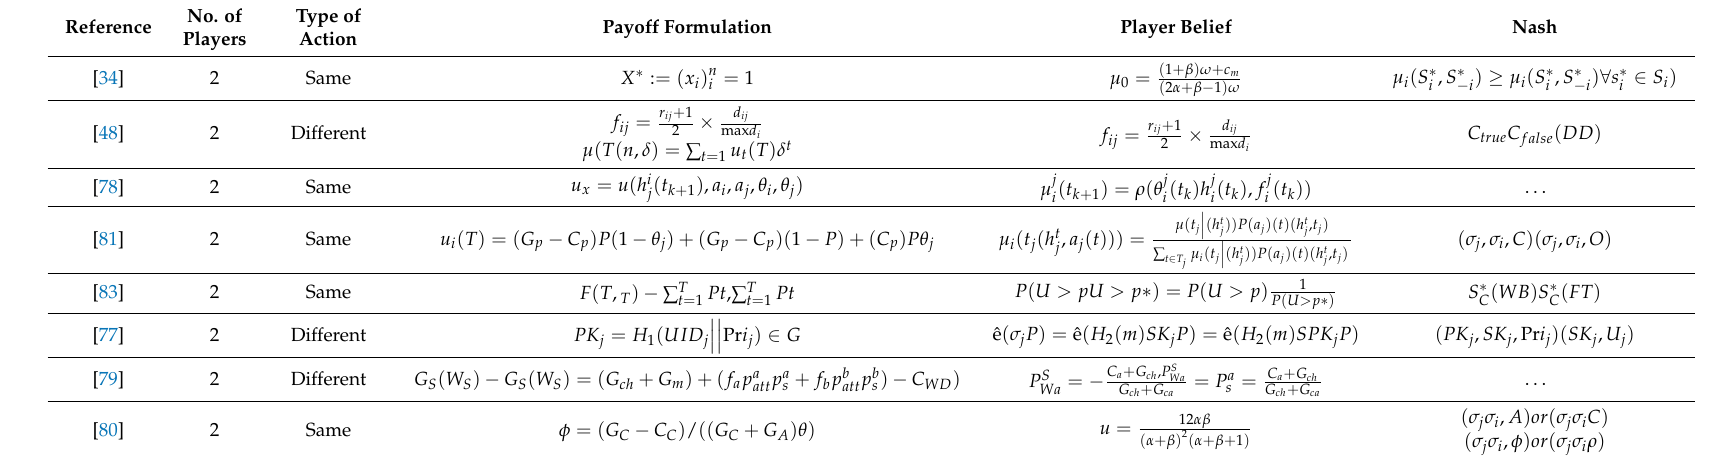
Table A3. Mathematical Comparison of Dynamic Bayesian games